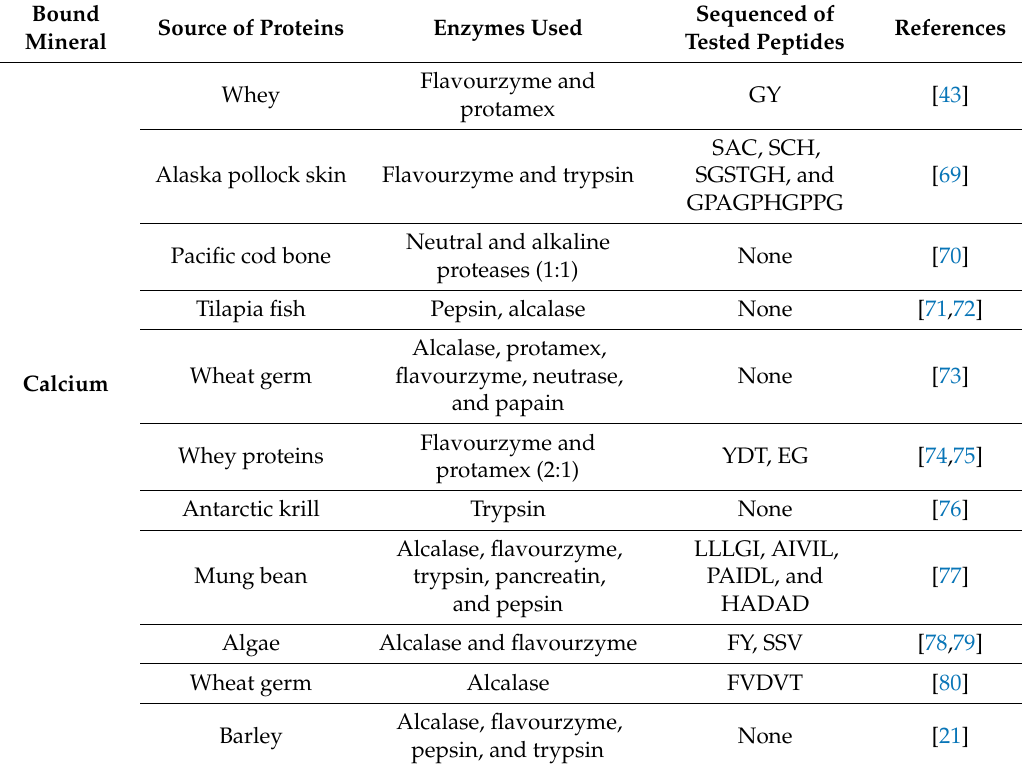
Table 1. Hydrolyzed food proteins and peptides with calcium and iron chelating